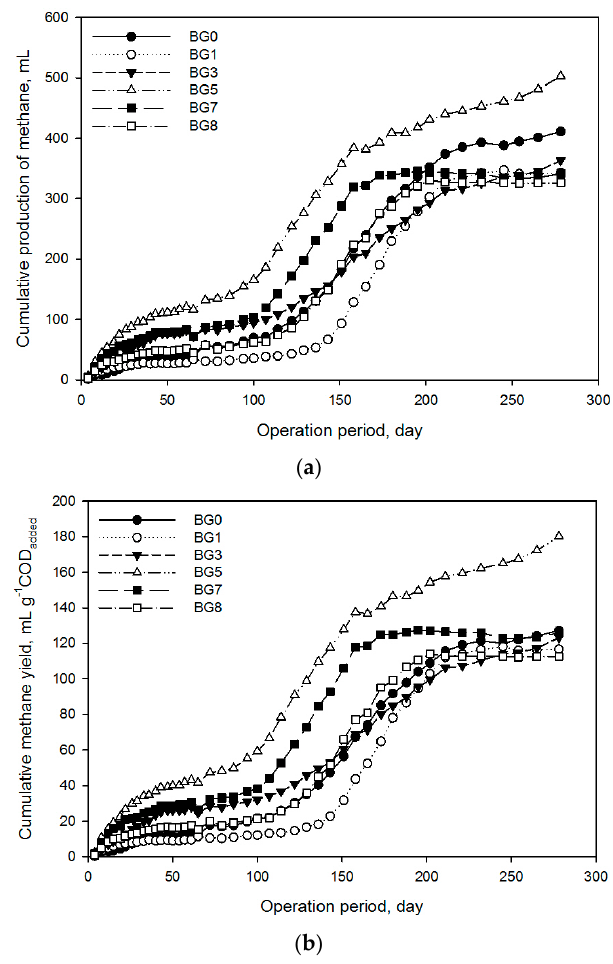
Figure 1. Cumulative methane production ( a ) and yield ( b ) of struvite precipitated substrates from the acidogenic digester treating poultry blood and wastewaters. Each point denotes the average value of three replicates.